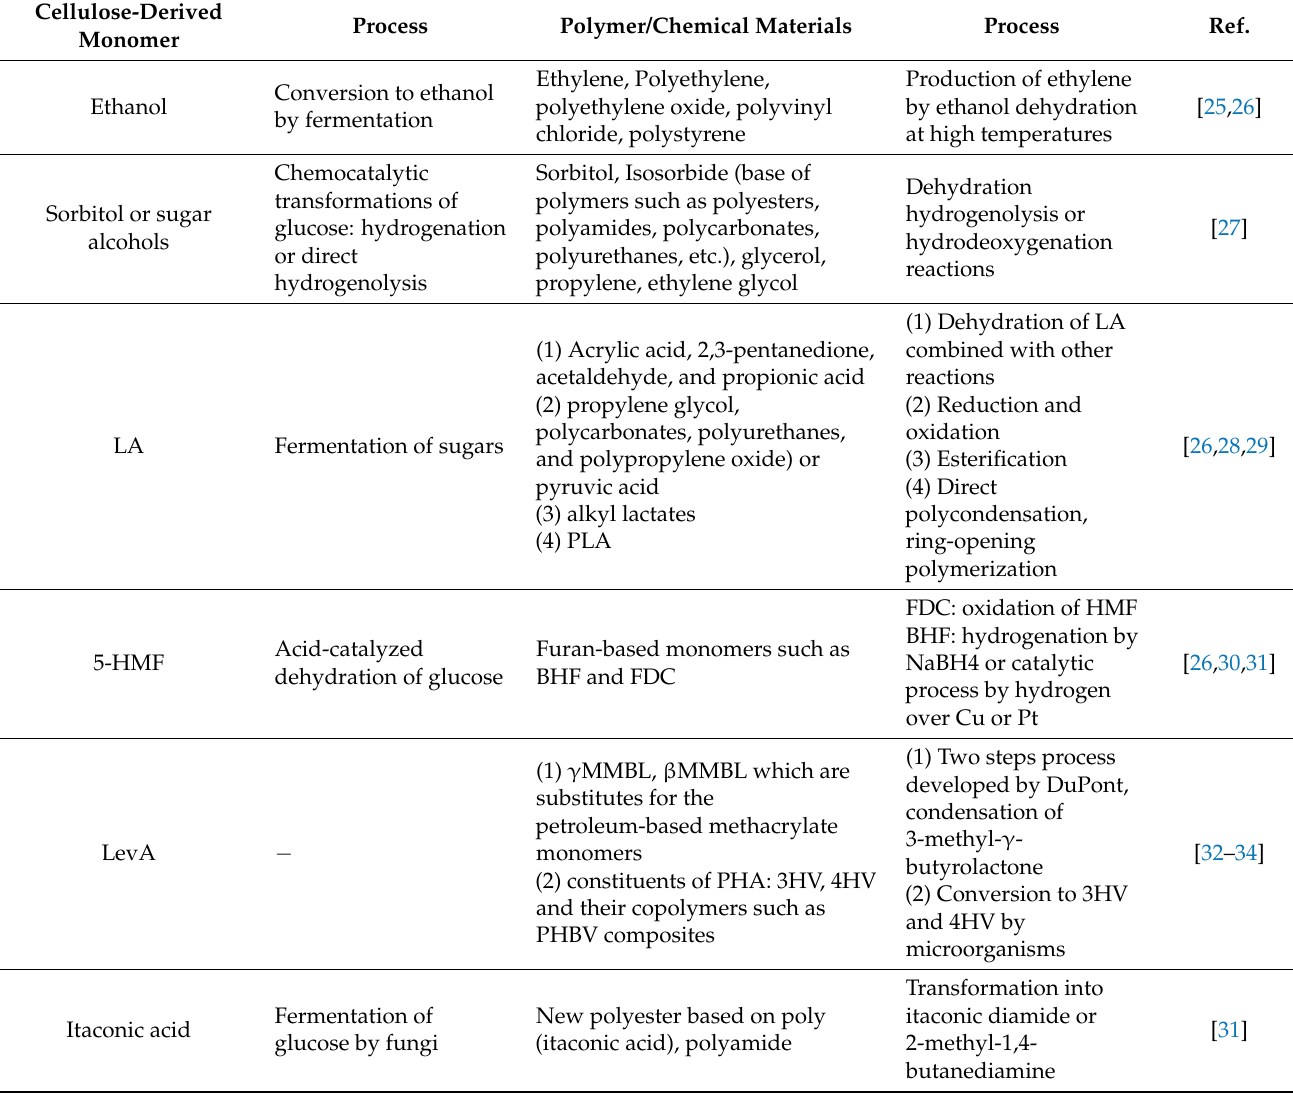
Table 1. Chemicals and monomer/polymer-based on cellulose and their